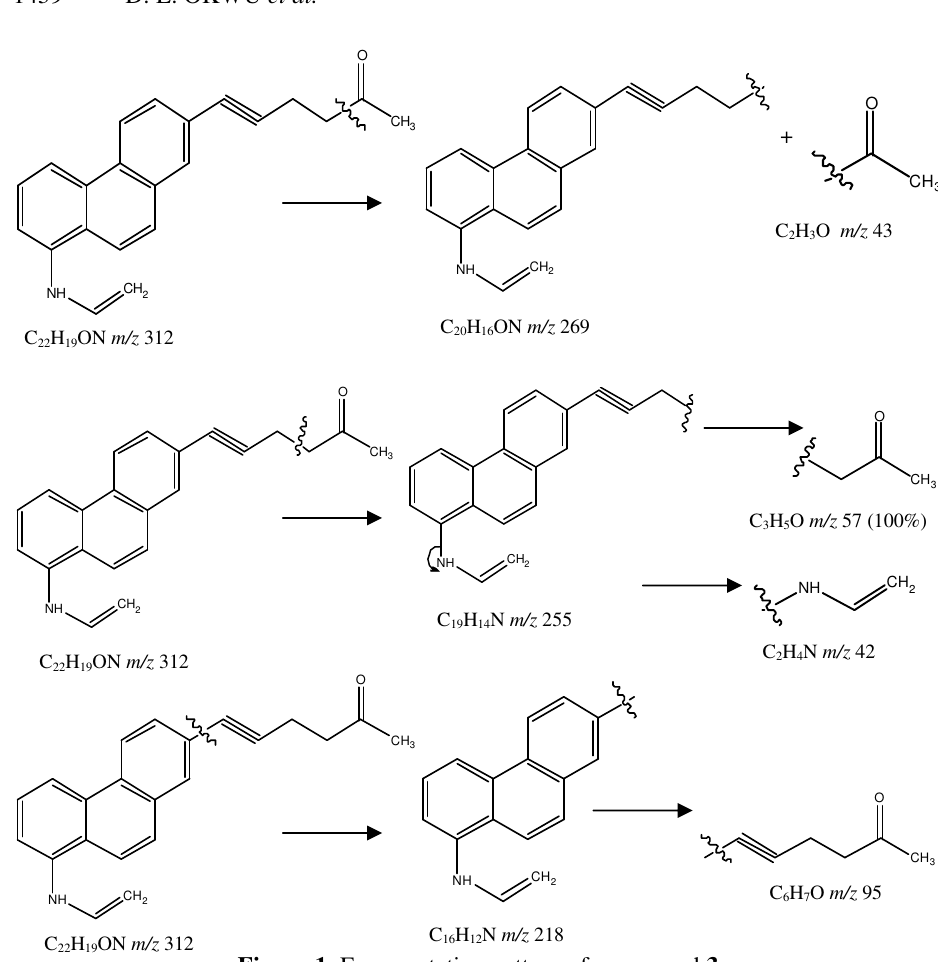
Figure 1. Fragmentation pattern of compound